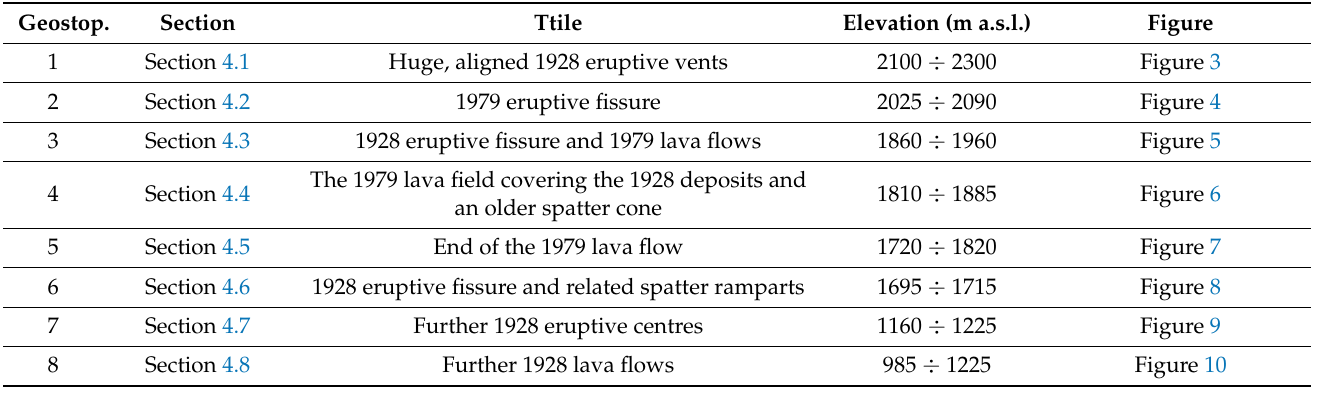
Table 1. List of the virtual geostops, together with the elevation range, the title and the corresponding section and figure.